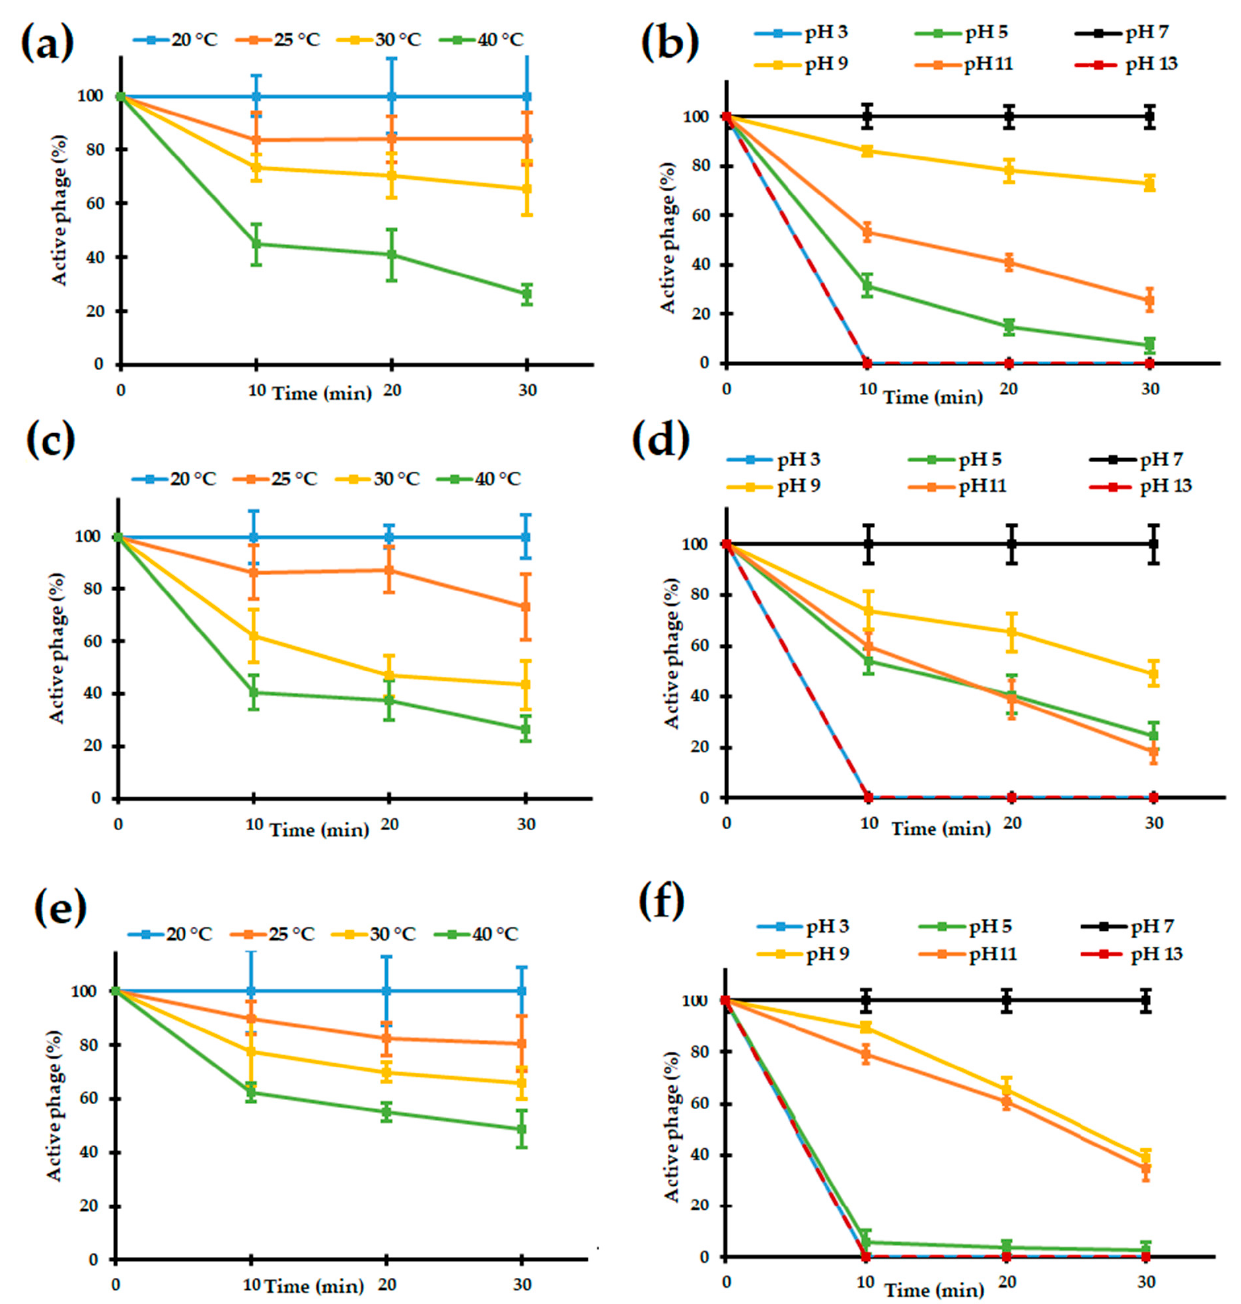
Figure 2. ( a , b ) Bolek, ( c , d ) Lolek, and ( e , f ) Tola phage stability under various temperatures and pHs. Temperatures and pHs are indicated according to the legends.